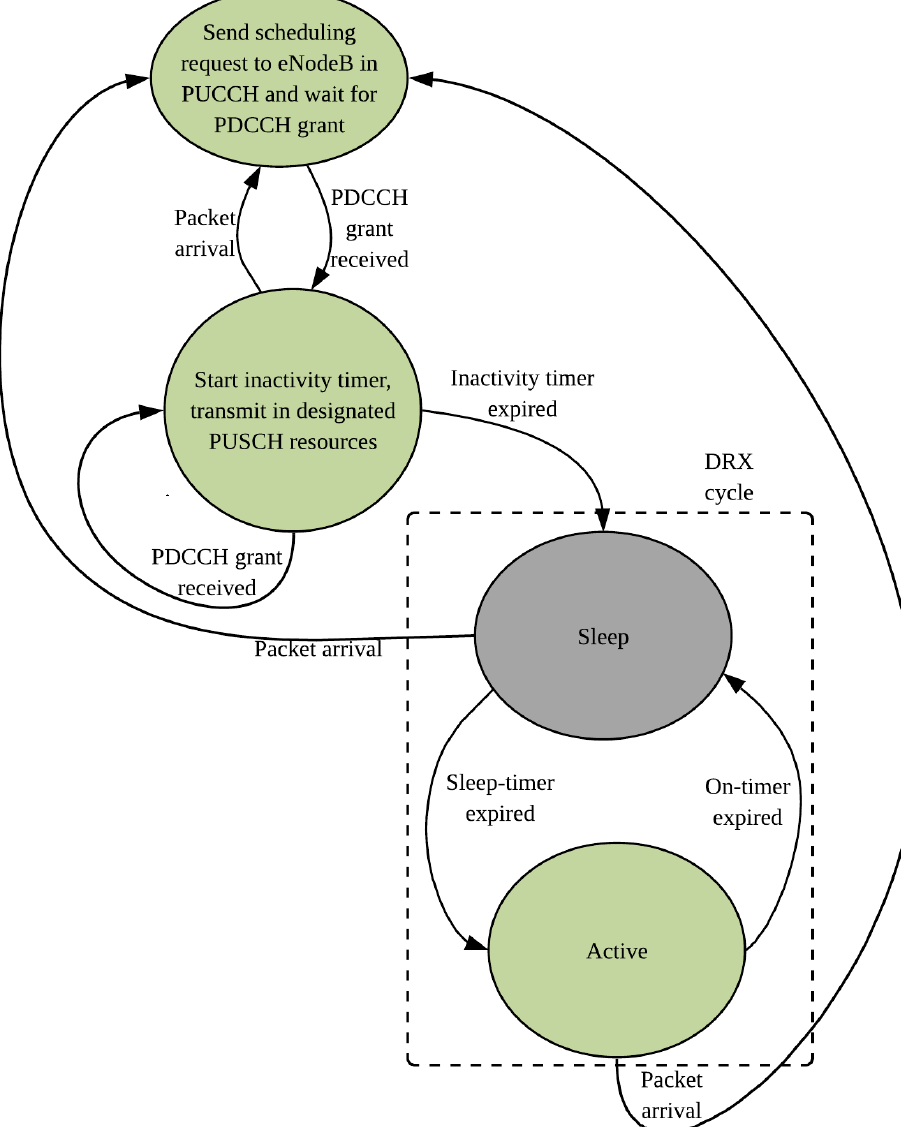
Figure 5. Standard Discontinuous Reception (DRX) mechanism from User Equipment (UE) perspec- tive (uplink only